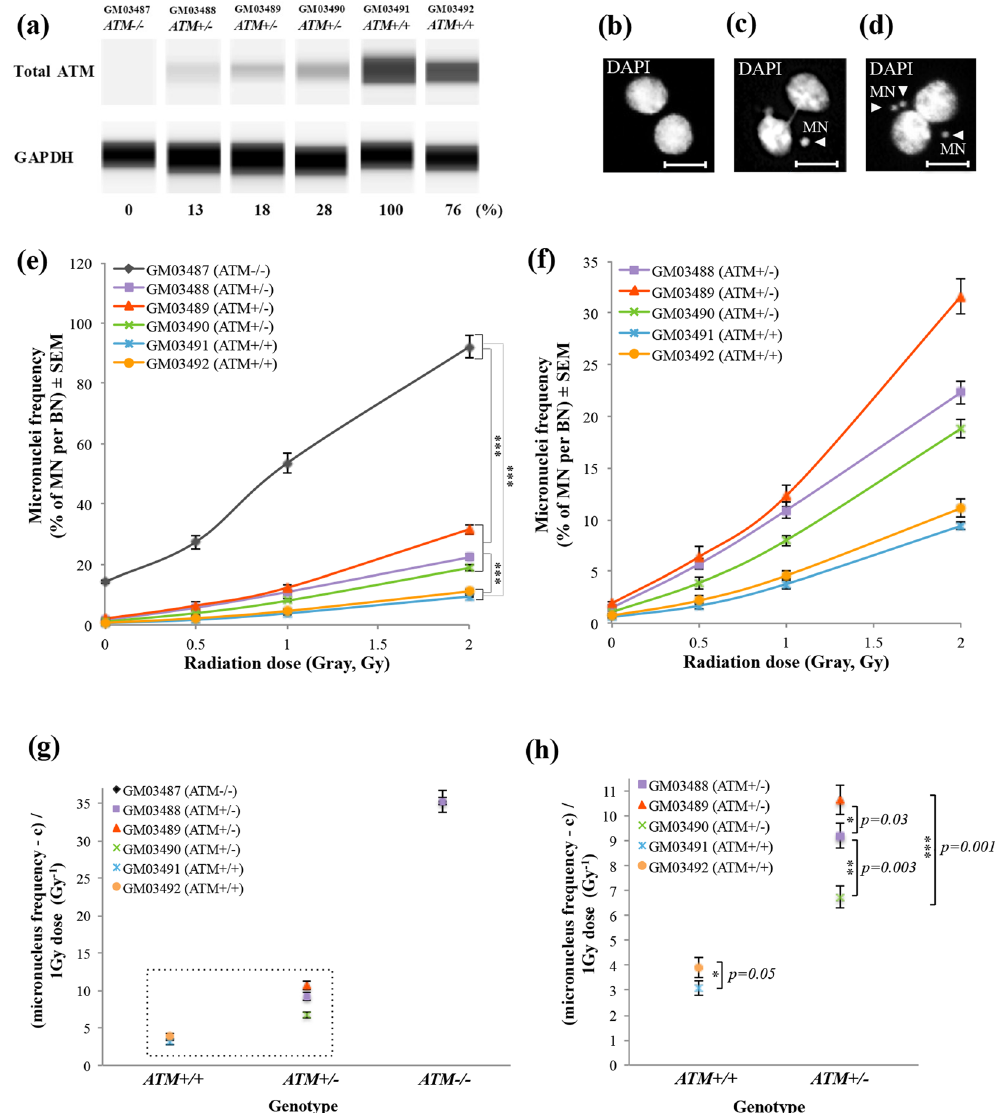
Figure 1. CBMN assays in primary fibroblasts detected the effect of different genetic backgrounds on radiosensitivity. ( a ) Western blotting analysis data showing the expression levels of ATM protein in primary fibroblasts derived from the six members of an A-T-affected family. The GAPDH antibody was used as a loading control. The intensity of ATM bands was normalized to that of GAPDH and is shown as a percentage regarding the score of GM03491, with the maximal ATM expression set as 100%. ( b – d ) Metafer MN Search images showing the cytokinesis-blocked fibroblasts stained with DAPI. BN cell without MN (b), BN cell with one MN (d); BN cell with three MN (e). Arrowheads indicate the MN. Scale bars: 10 μ m. (e) Percentage of IR-induced MN formation in fibroblasts from all members of the A-T-affected family (mean ± SE; t-test; *** p < 0.001, ** p < 0.01, * p < 0.05; n = 3; > 1000 BN cells, > 50 BN cells only in A-T patient fibroblasts). ( f ) The graph from (e) with magnification of the Y-axis including the percentage of IR-induced MN formation in fibroblasts derived from A-T heterozygous carriers and unaffected individuals. ( g ) Radiosensitivity in the six members of the A-T- affected family was quantified using the sum of α and β coefficients upon γ -ray irradiation at 1Gy (mean ± SE; t-test; n = 3; > 1000 BN cells per experiment, > 50 BN cells per experiment only in A-T patient fibroblasts). A-T patient cells showed a remarkable rasiosensitivity score. (h) The graph from (g) with magnification of the Y-axis including the radiosensitivity scores of A-T heterozygous carriers and normal individuals in the A-T-affected family. Significant inter-individual differences in radiosensitivity are denoted by asterisks (mean ± SE; t-test; *** p < 0.001, ** p < 0.01, * p < 0.05; n = 3; > 1000 BN cells per experiment). Cropped blots are displayed and the full-length blots are included in the Supplementary Information